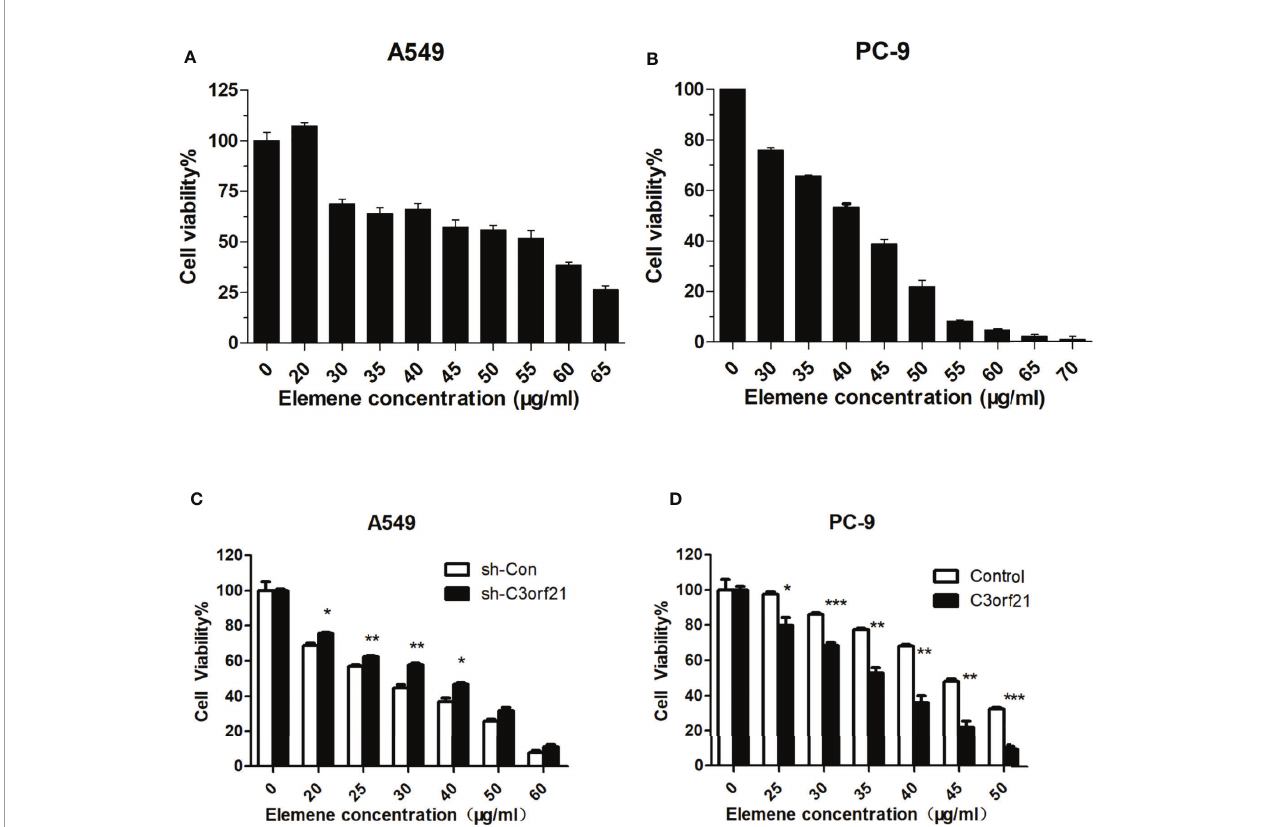
FIGURE 5 | Beta-elemene inhibits the proliferation of NSCLC cells. A549, PC-9, A549-shNC and A549-shC3orf21 cells were treated with, or without, the indicated concentrations of beta-elemene for 24 h and the cell proliferation was determined by CCK-8 assays. Data are expressed as the mean ± SD of each dose group from three biological experiments. (A, B) The proliferation of A549 cells. (B) The proliferation of PC-9 cells. (C) The proliferation of A549-shNC and A549-shC3orf21 cells. (D) The proliferation of PC-9-NC and PC-9-C3orf21 over-expression. *P < 0.05, **P < 0.01 and ***P < 0.001 vs. the